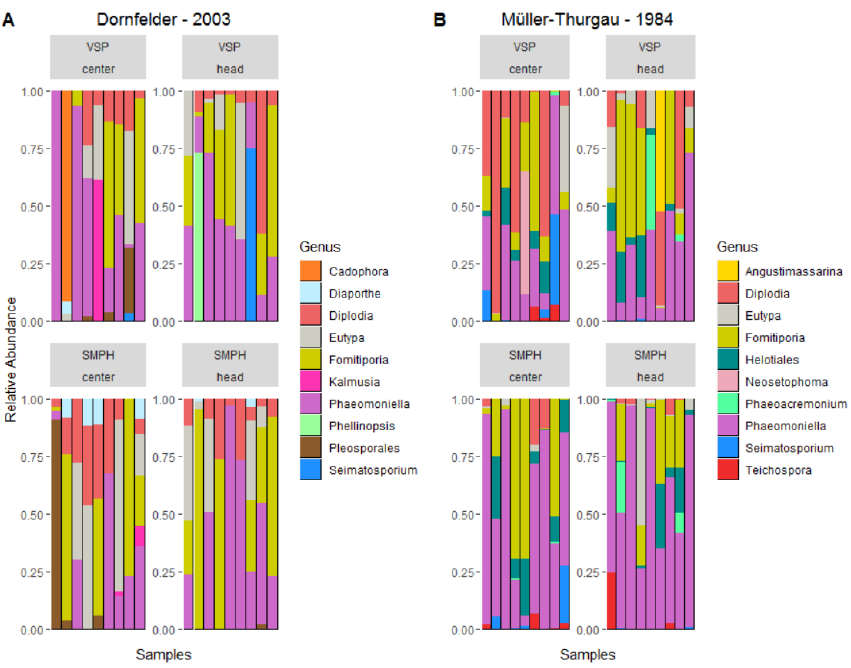
Figure 7. Relative abundance of the top ten genera, which are not assigned to ‘Unknown’, found in the wood samples collected from the ( A ) ‘Dornfelder’ and ( B ) ‘Müller-Thurgau’ vineyards. Samples were grouped by training system (VSP and SMPH) and origin (trunk center and trunk head).